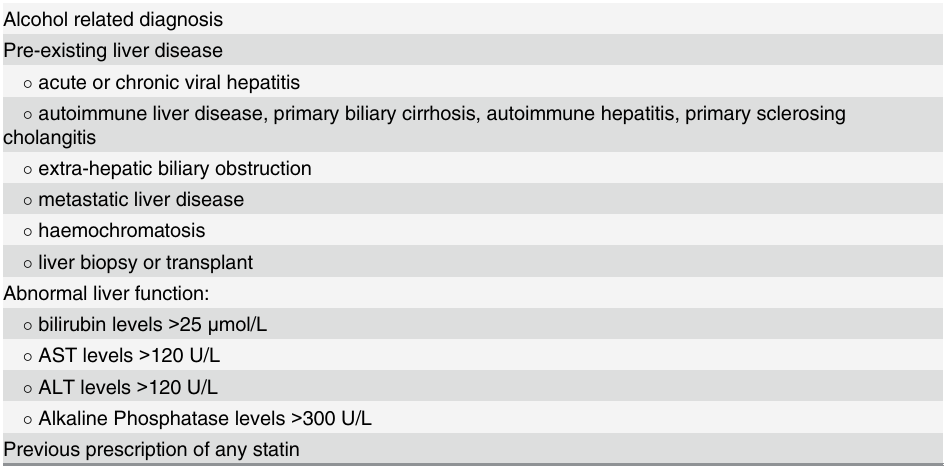
Table 1. Exclusion criteria for patient selection prior to index date of statin